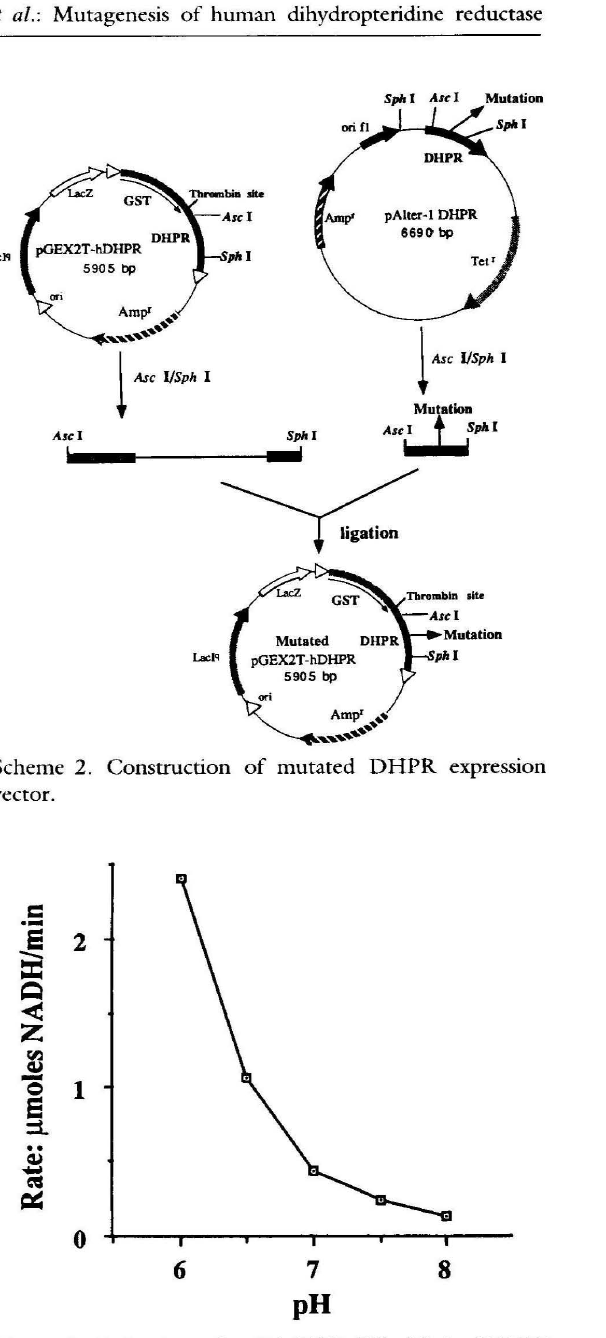
Figure 1. Reduction of q-6MeDHP (25 JlM) by NADH (100 JlM). ed with MTPBS and fractions (2 ml) were col lected. The protein, in fractions 1-5 (one band at Mr -26 K on SDS-PAGE), was concentrated, the buffer replaced and stored as above. The fusion proteins and unconjugated DHPRs were stored in 50 mM Tris HCl pH 7.4 containing 2 mM DIT at -20°, preferably in the presence of 20 mM NADH to stabilise the active site. A Pharmacia Phast-System at 16° was used for